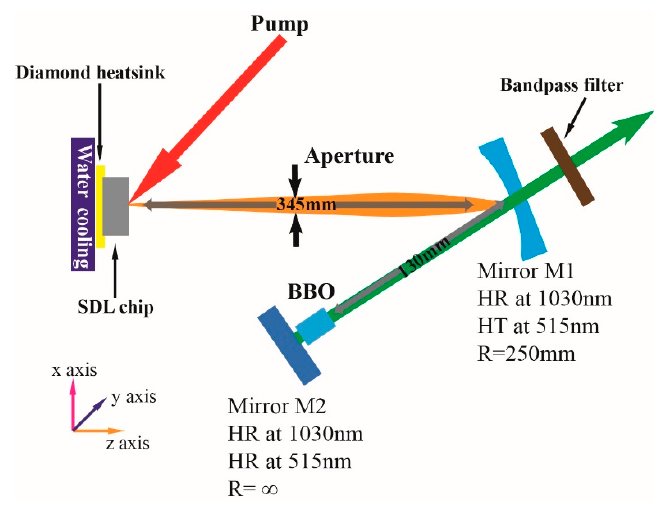
Figure 3. Schematic of the V-shaped resonator for green laser.